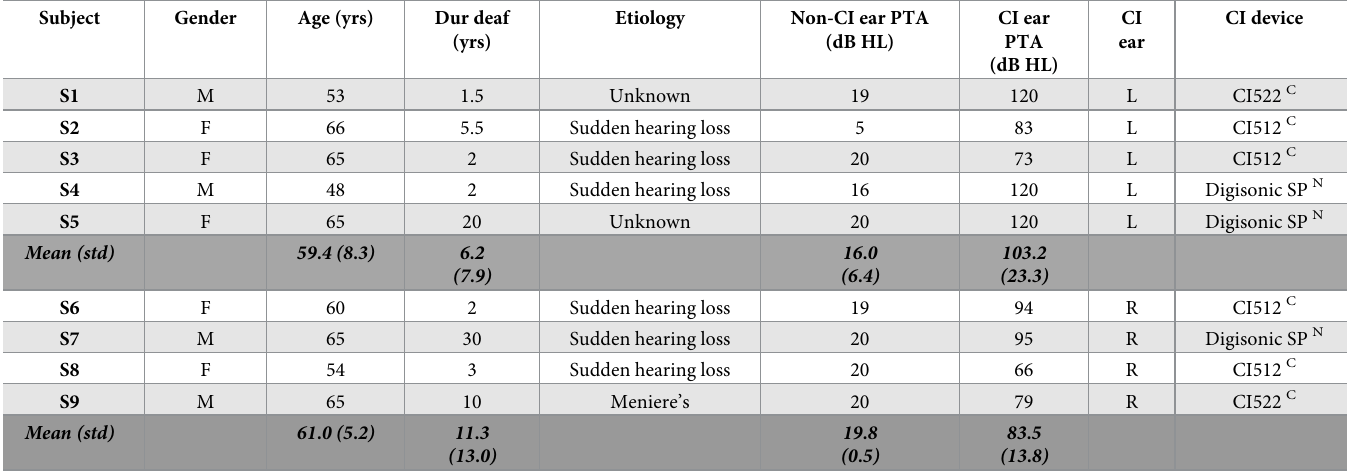
Table 1. Demographic information for the present SSD-CI subjects.